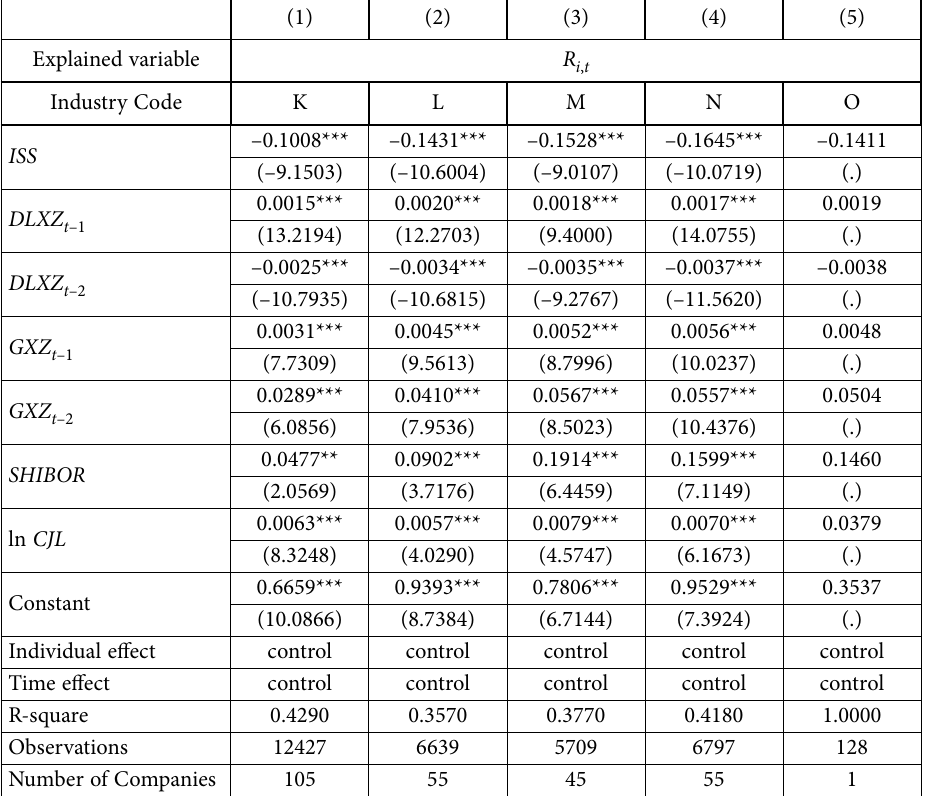
Table 10. Influence of information infection on stock market